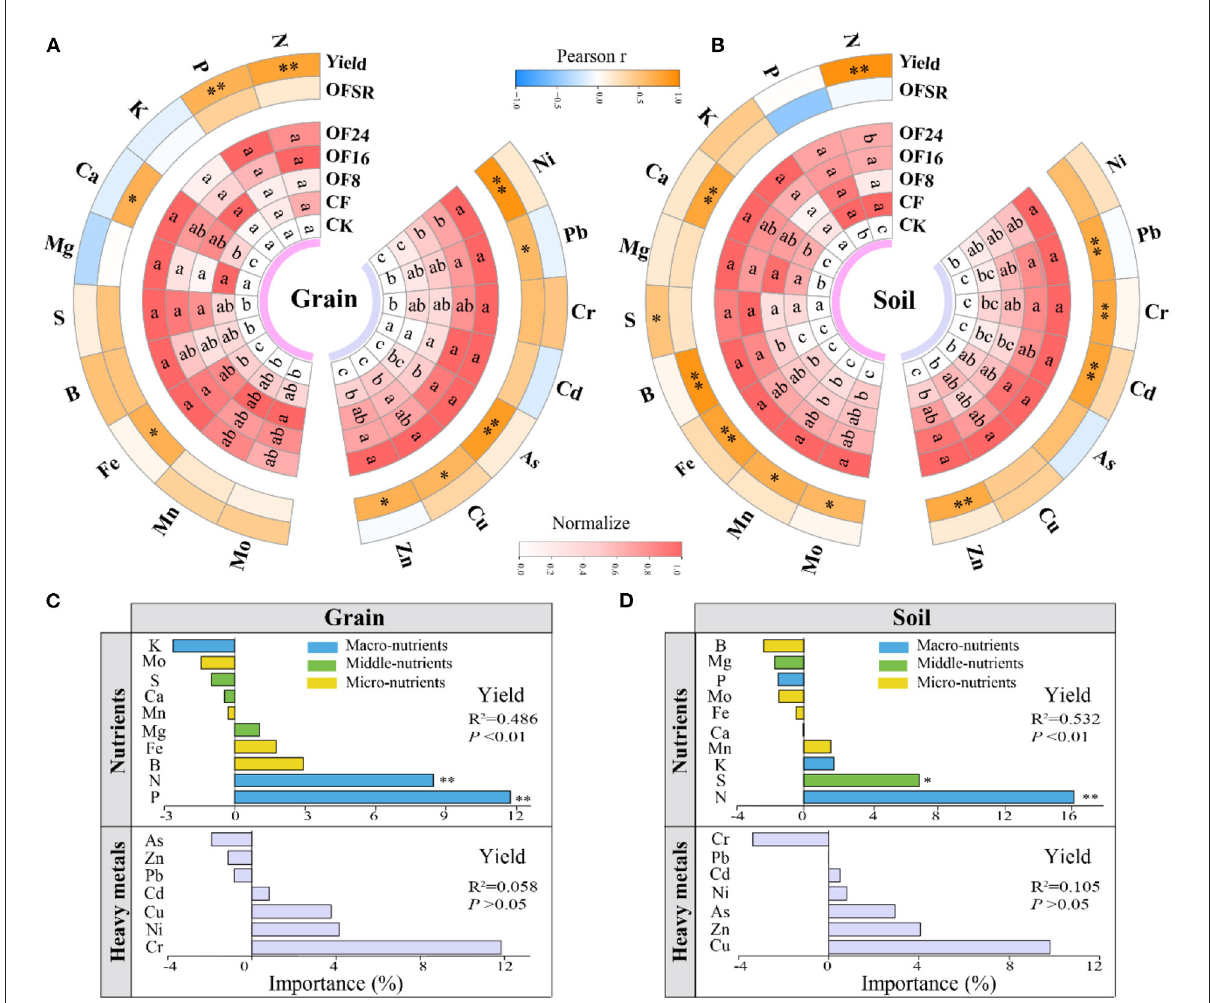
FIGURE4 Effects of different treatments on nutrients and heavy metals in maize grain (A) and soil (B) , as well as their correlation with organic fertilizer substitution ratio (OFSR) and yield. Random forest analysis predicts the key factors affecting yield in maize grain (C) and soil (D) . In panels (A,B) , the degree of shades of red is positively correlated with the normalized value (0–1) of each indicator ( n = 3). Different lowercase letters represent significant differences at the level of p < 0.05. * and ** represent significant differences at the level of p < 0.05 and p < 0.01,